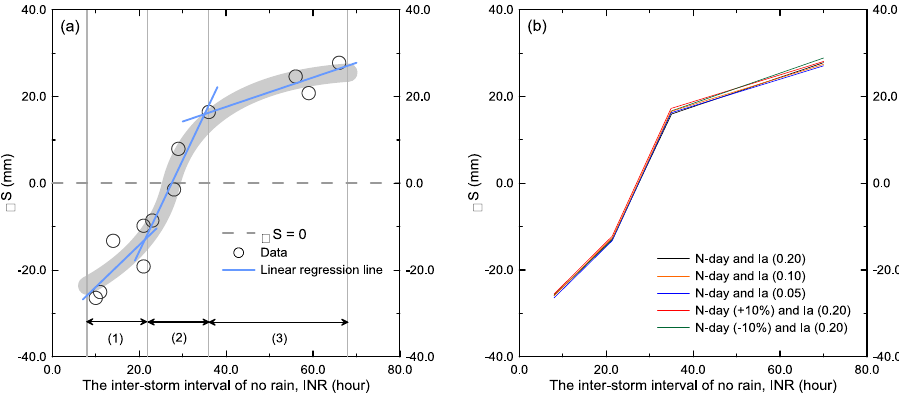
Figure 8. Derivation of R-curve for the Napa River basin, based on the sixteen rainfall events. In the